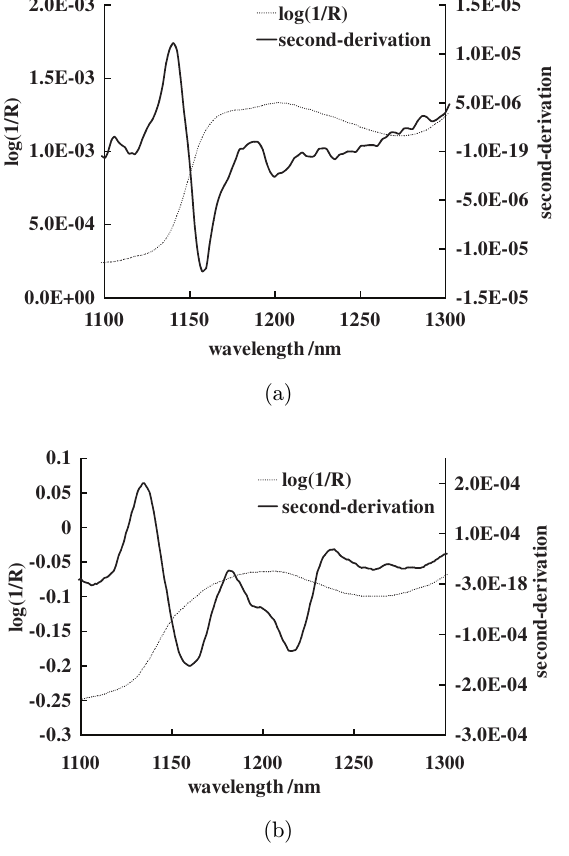
Fig. 4. Re°ectance and second-derivation of (a) water and (b) human skin.